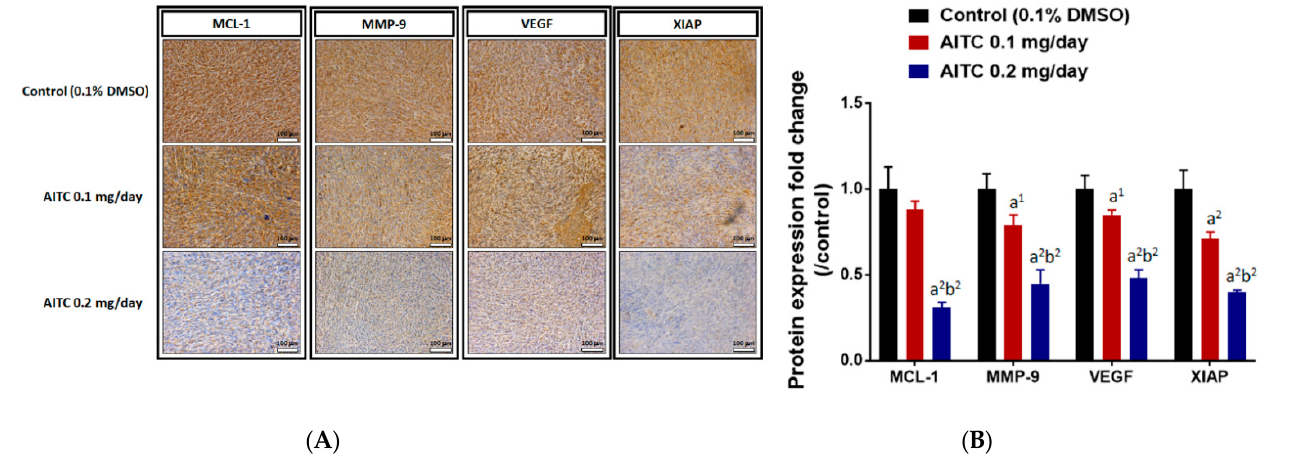
Figure 5. AITC suppressed the expression of tumor-progression-related proteins. Tumors were isolated from each group and further examined by IHC staining. The IHC staining images of MCL-1, MMP-9, VEGF, XIAP on the tumor were observed by microscope at 100 times magnification ( A ). The quantification data of MCL-1, MMP-9, VEGF, XIAP expressions is presented ( B ). (a 1 p < 0.05, a 2 p < 0.01 vs. control; b 2 p < 0.01 vs. AITC 0.1 mg/day). Each section was imaged with 3 independent fields and quantified. (Scale bar = 100 µm, with 200× magnification).